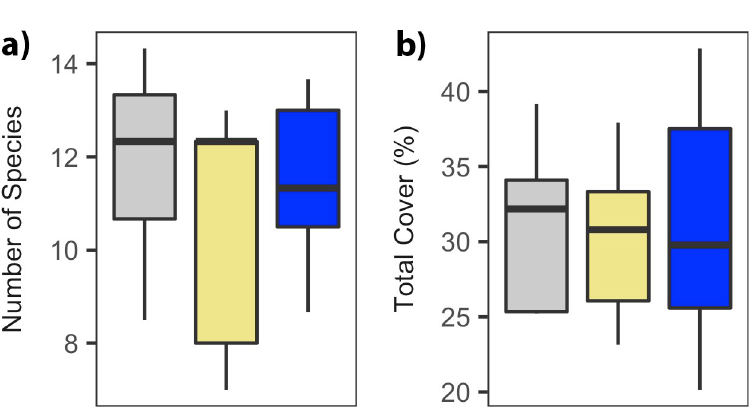
Fig 4. Total plant cover and species richness were unaffected by treatment application. Treatment is indicated by color (gray = control, khaki = hay addition, blue = nitrogen addition). a) species richness, and b) plant abundance.